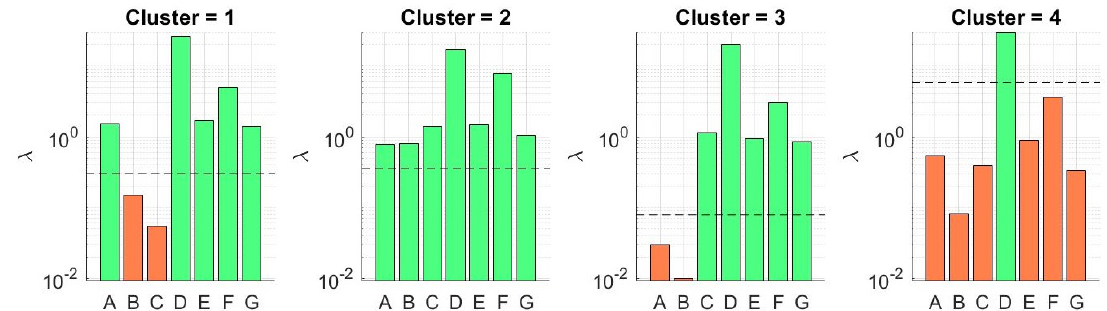
Figure 10. The new λ -levels for sensor selection for each cluster using the weighted group lasso method for δ h = 30. A, B, C, D, E, F, and G represent environmental temperature, body temperature, humidity, EDA, HR, wrist accel, and ankle accel,